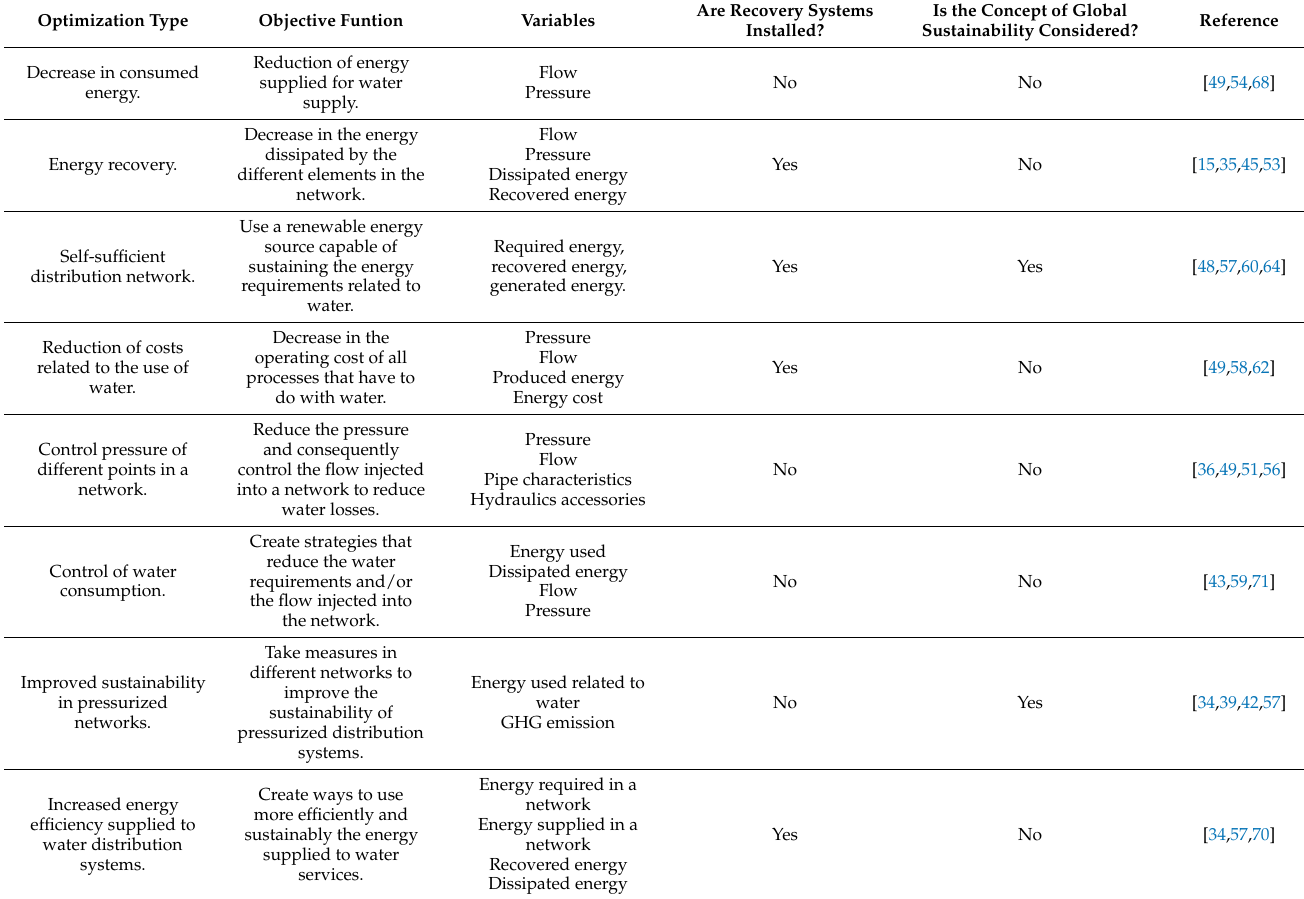
Table 2. Optimization of applied techniques in water